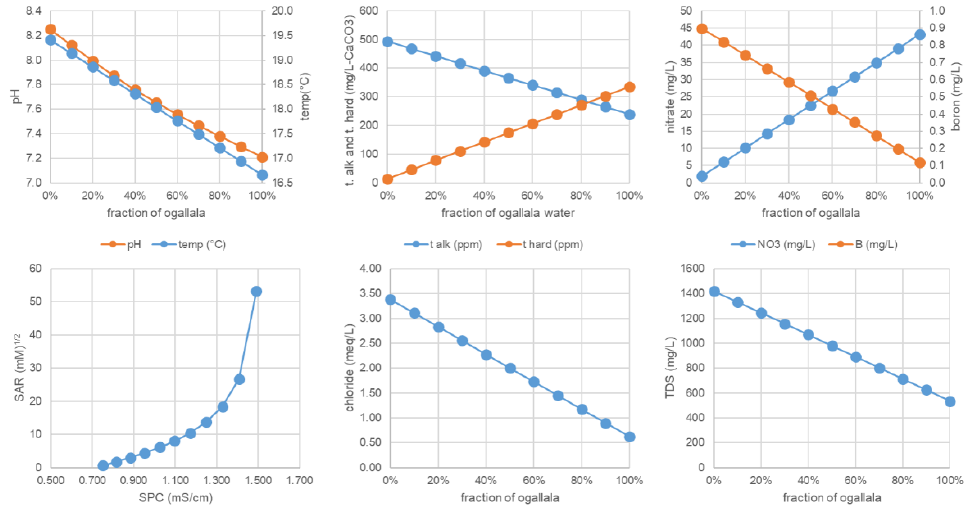
Figure 13. Summary PHREEQC blending results for spring 2015 water samples from the southwest study region.